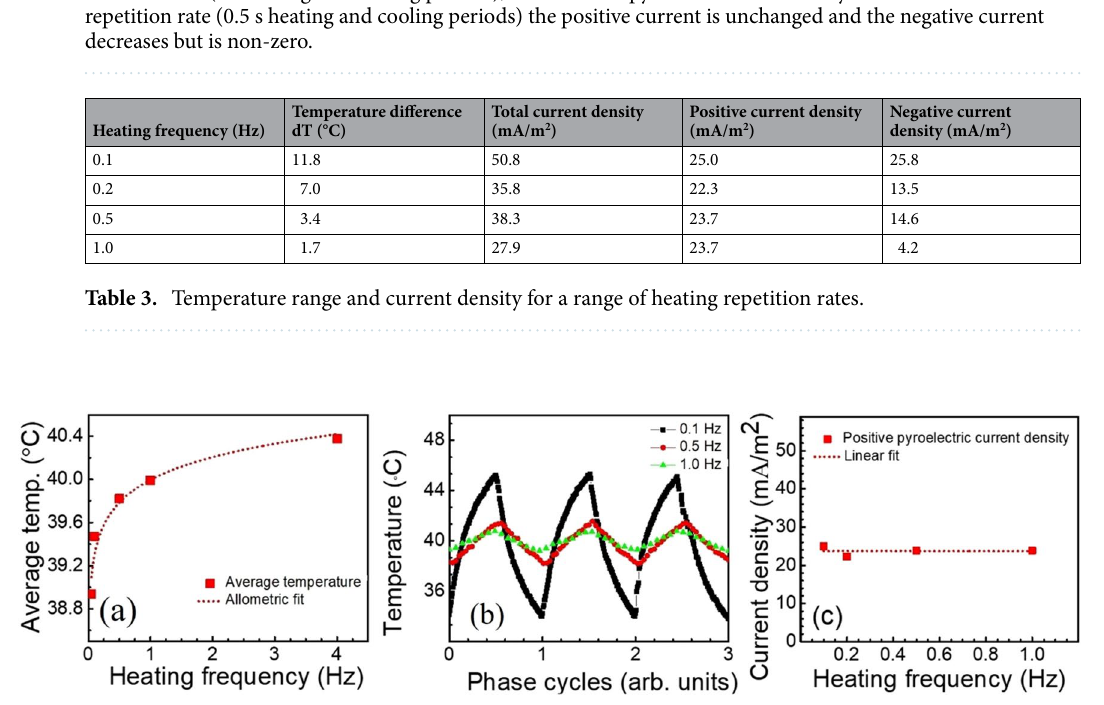
Figure 8. Plot of ( a ) average temperature for different heating frequency, ( b ) the amplitude of temperature change as a function of the phase cycle at heating frequencies, and ( c ) pyroelectric current density versus heating frequency for positive-going current